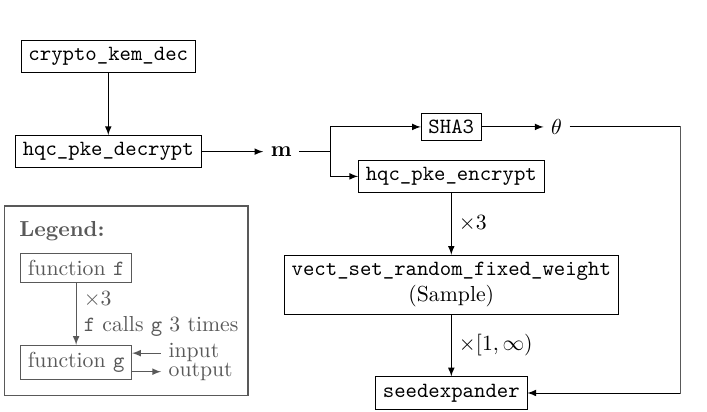
Figure 1: Visualization of the information flow in the decapsulation function of the current HQC KEM implementation [AAB +